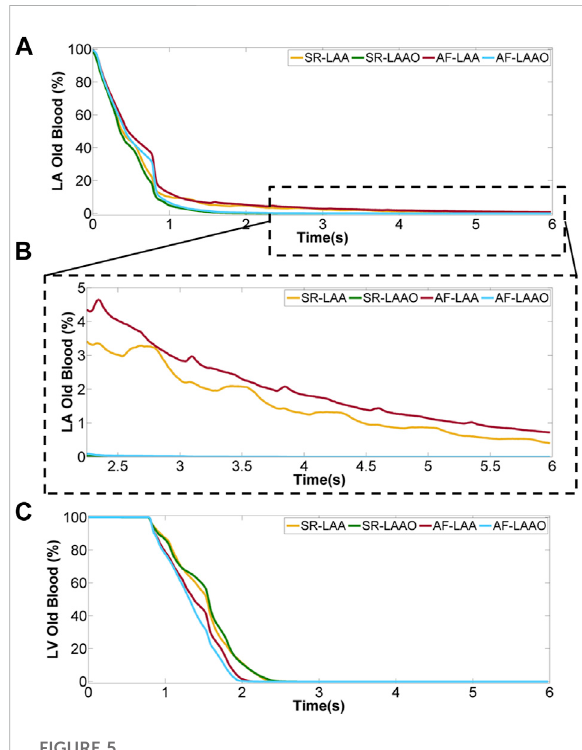
close-upforlast5cycles (B) andventricle (C)